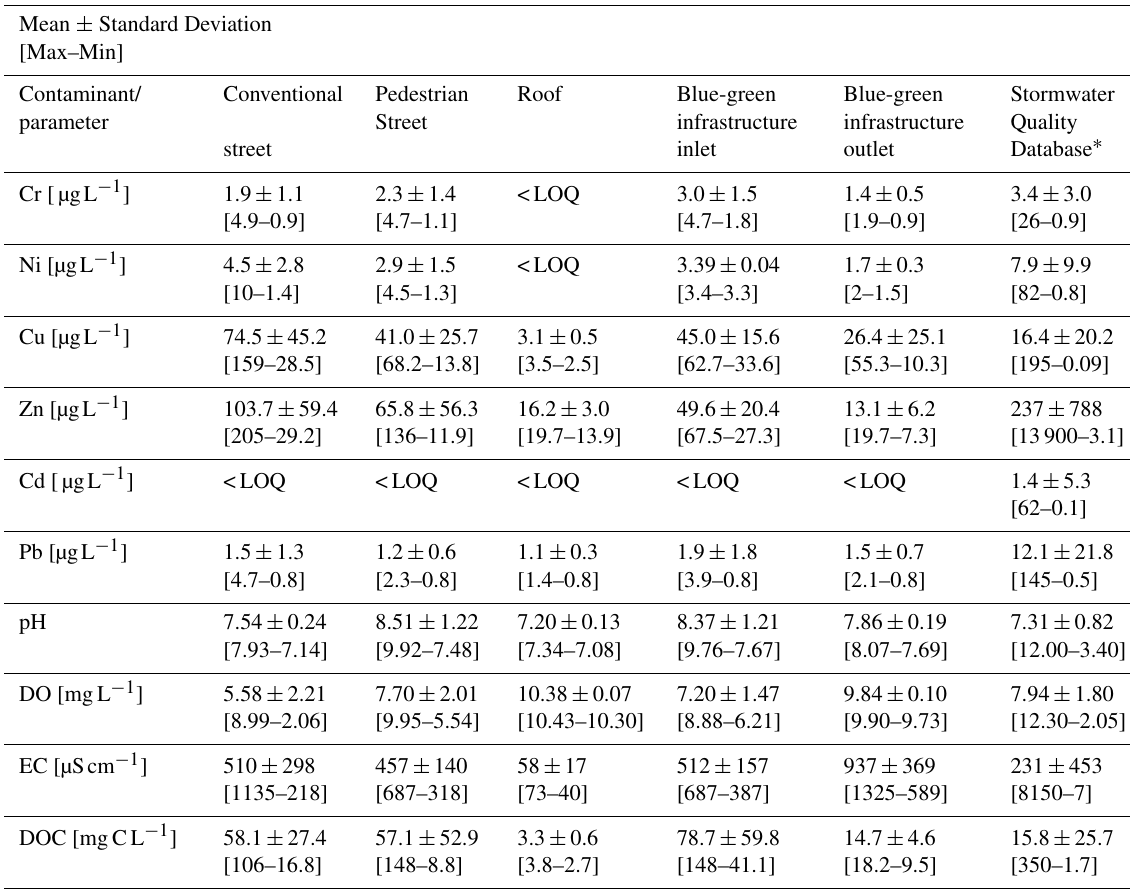
Table 1. Average concentration of selected trace metals (µgL − 1 ; parts-per-billion) and complementary water quality parameters of Barcelona stormwater runoff. Standard deviations are given after ± . Maximum and minimum values are given between